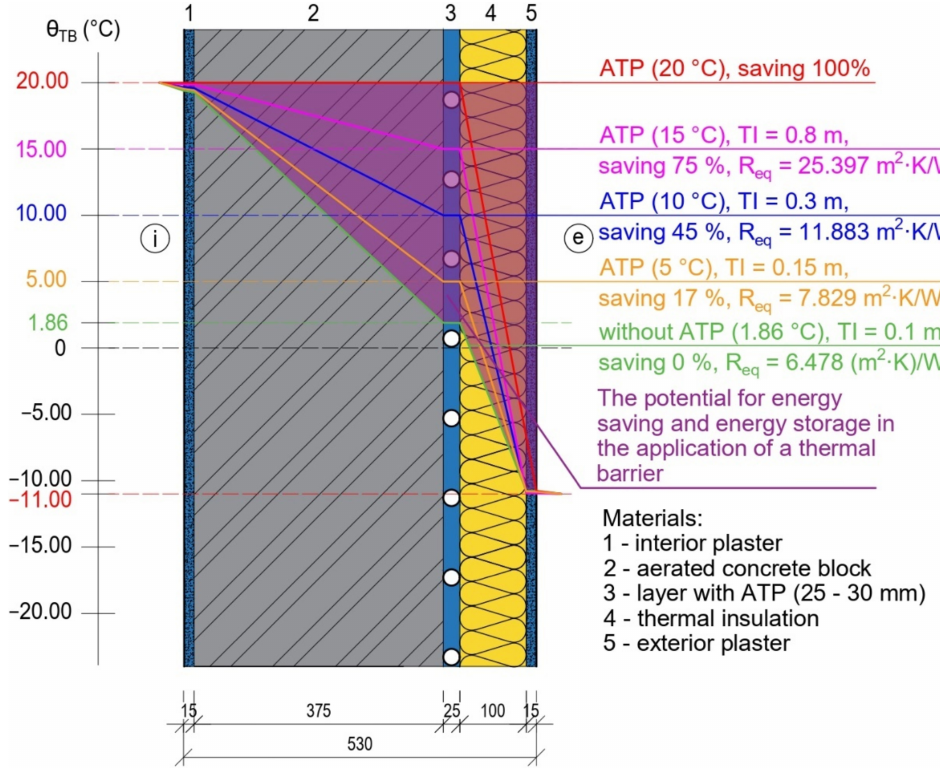
Figure 18. Mathematical-physical model of construction with isotherms for heating.